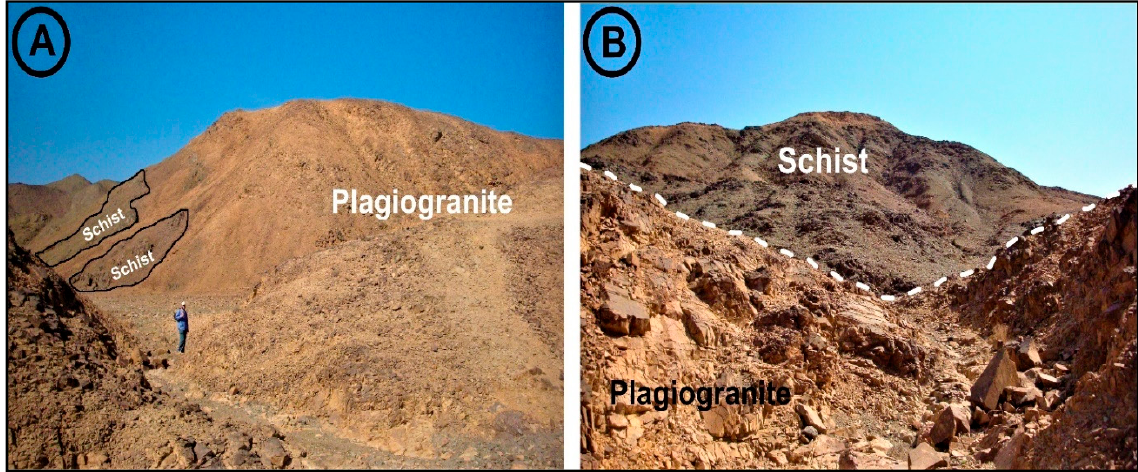
Figure 2. Field photographs of plagio-granite blocks encountered in Wadi Abu Dabbab. ( A ) Highly weathered plagio-granites. ( B ) Jointed plagio-granites intruded within volcaniclastic metasediments at Wadi Abu Dabbab .